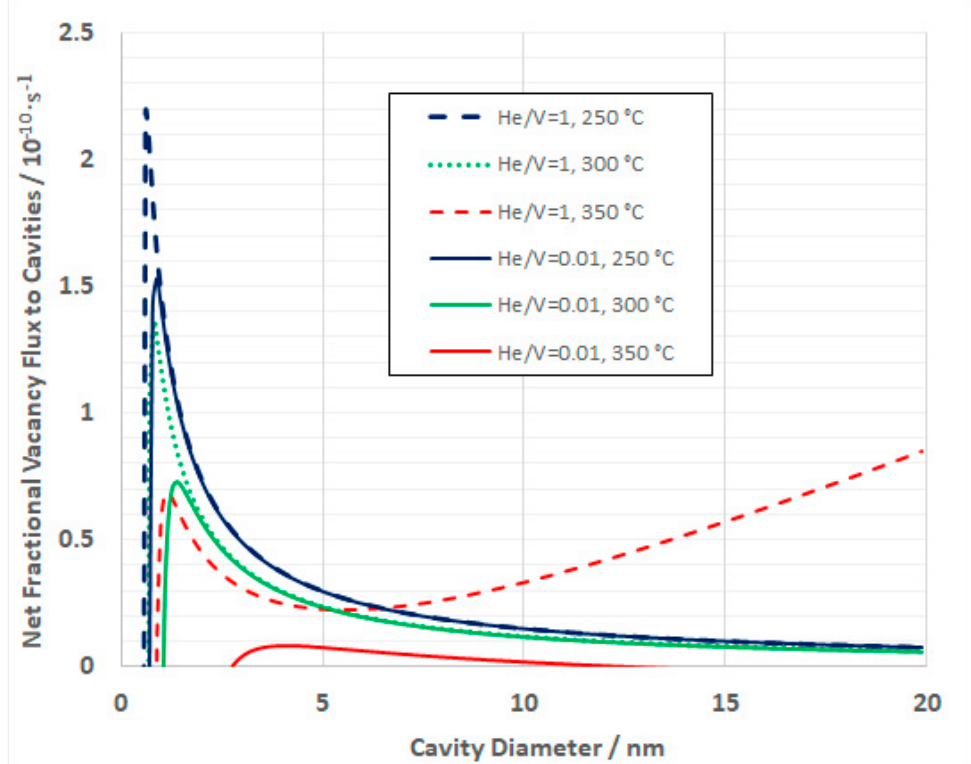
Figure 10. Net vacancy flux to cavity sinks as a function of cavity diameter for Inconel X-750 irradiated in a generic reactor.